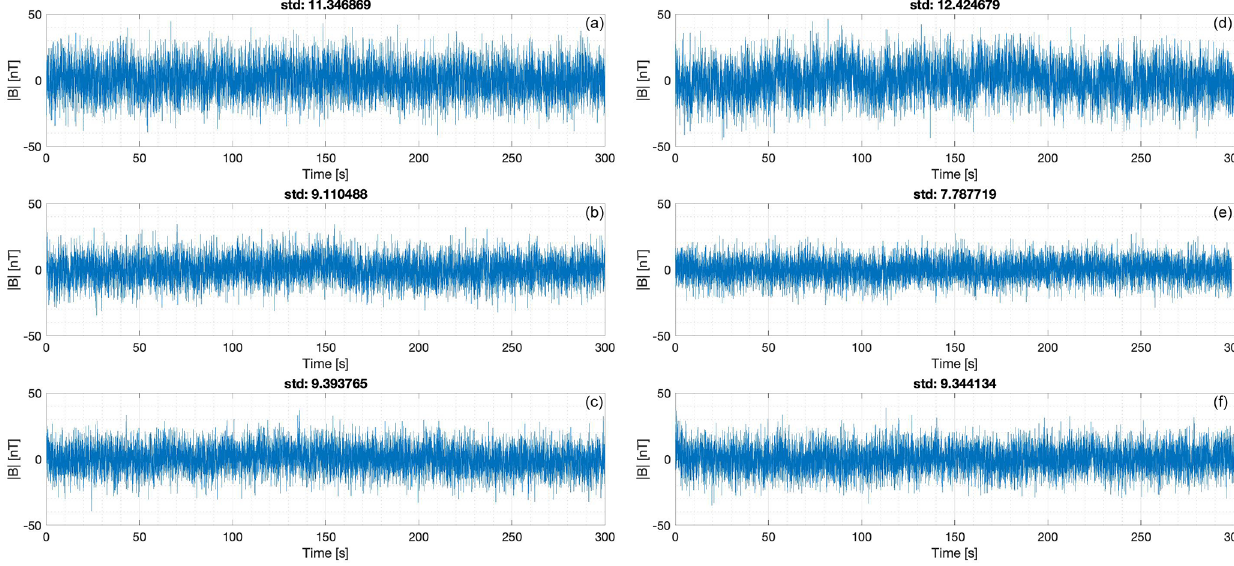
Figure 9. Pre- and post-exposure (left and right panels, respectively) measurements of the magnetic field inside the zero-Gauss chamber at the University of Michigan for the three sensors used during the University of Michigan test